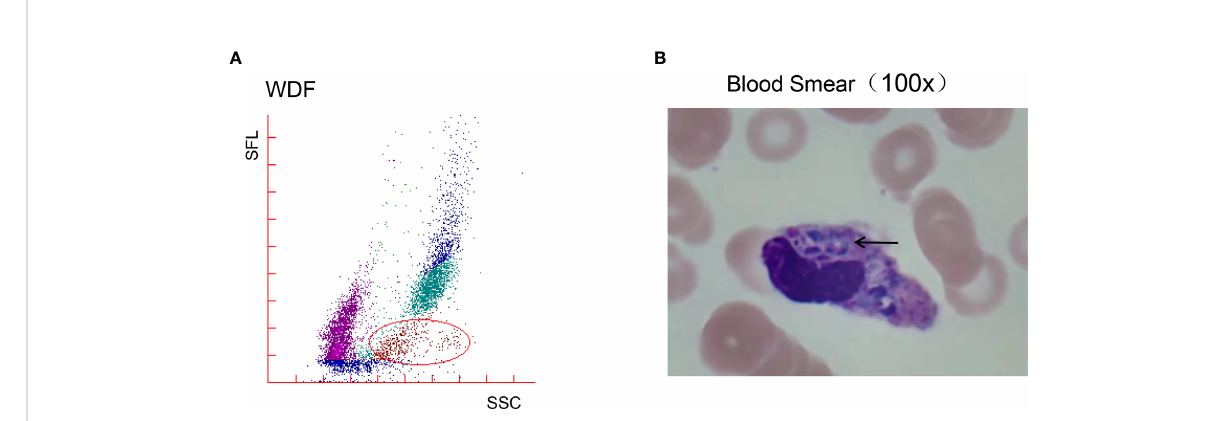
FIGURE 1 White blood cell (WBC) count analysis revealed abnormal cell masses and a microscopic morphology. (A) The WBC differential channel of the Sysmex XN-3000 ™ Automated Hematology Analyzer suggests the presence of abnormal cells. The area shown in the circle originally belonged to mature granulocytes, but the scatters were not concentrated, and the apparatus de fi ned these cells as eosinophils (shown in red). (B) A peripheral blood smear revealed scattered phagocytic phenomena in fungal spores and mature granulocytes, with oval fungal spores, small nuclei, a purple color, deviation to one side, pale blue plasma, and the entire pro fi le resembling corn, with a morphology consistent with Talaromyces marneffei .